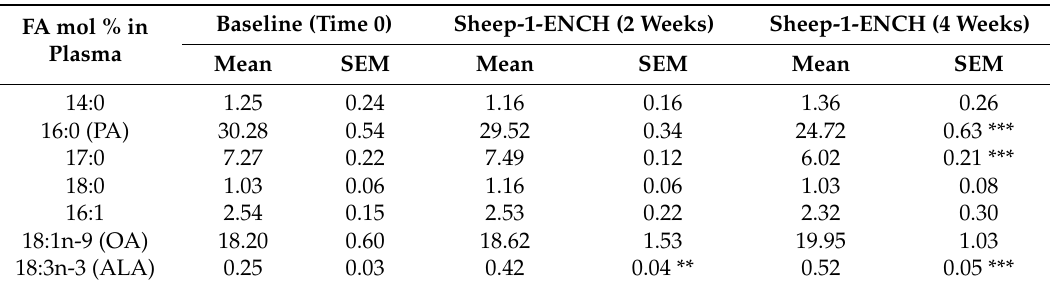
Table 1. Main fatty acids (FA) in the plasma of subjects consuming 90 g/day of a conjugated linoleic acid (CLA)-enriched (ENCH) sheep cheese (sheep-1-ENCH). PA, palmitic acid; OA, oleic acid; ALA, α -linolenic acid; EPA, eicosapentaenoic acid; DHA, docosahexaenoic acid; LA linoleic acid, ARA, arachidonic acid. The data are expressed as mol % and represent the mean ± SEM for 15